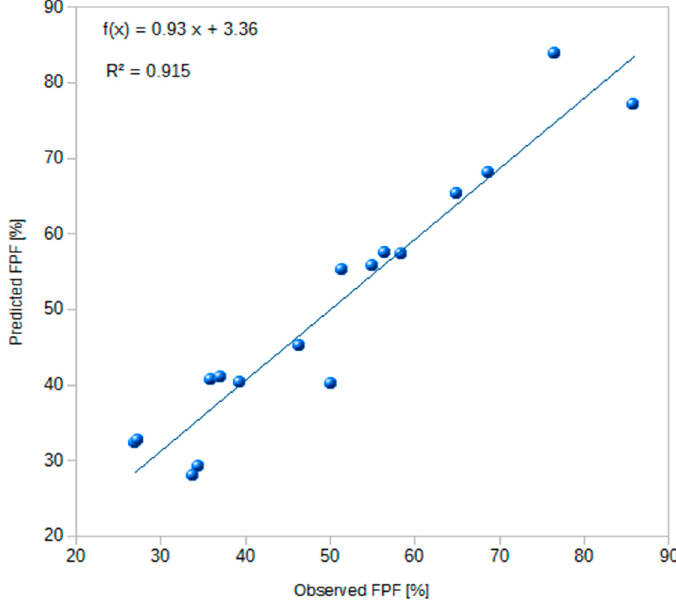
Figure 3. Comparison of FPF values predicted by the model and obtained in laboratory experiments. FPF—fine particle fraction.